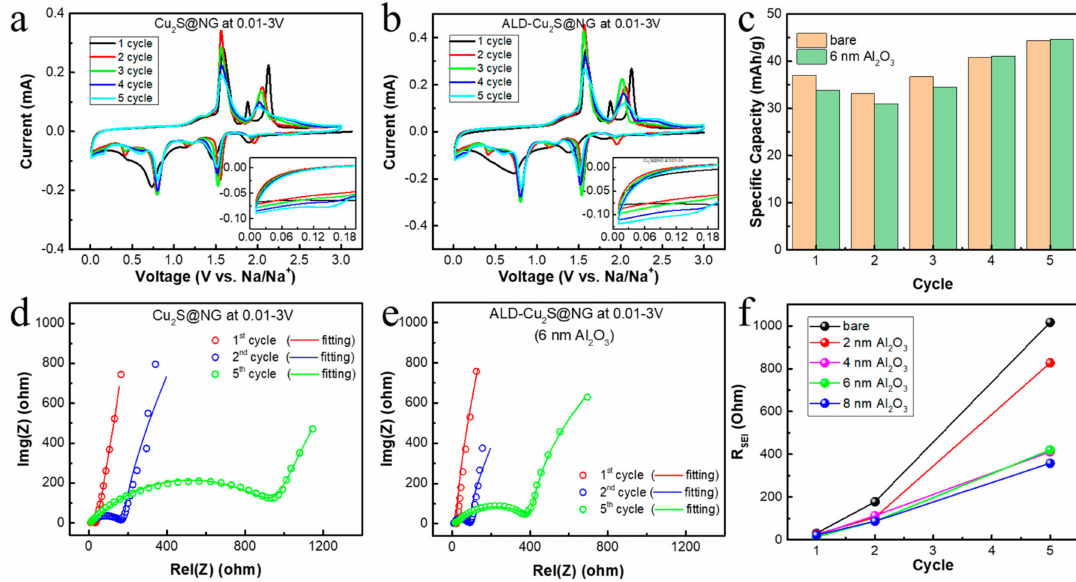
Figure 4. Cyclic voltammetry profiles of ( a ) the bare Cu 2 S@NG and ( b ) the ALD-modified Cu 2 S@NG electrodes in the first 5 discharge–charge cycles. ( c ) Comparison of the discharged capacities in the range of 0.01–0.2 V for the first 5 cycles between the bare and ALD-modified electrodes. Nyquist plots with the fitting curves of electrochemical impedance spectroscopy (EIS) measurements of ( d ) bare and ( e ) ALD-modified electrodes in initial 3 cycles. ( f ) Comparison of the solid electrolyte interphase (SEI) film resistance between bare and ALD-modified